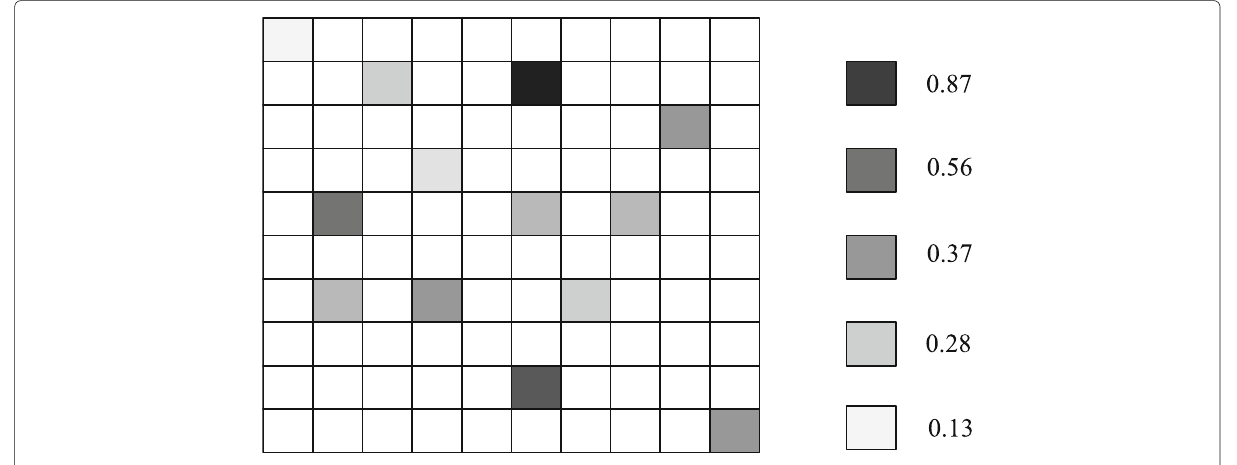
Fig. 3 The distribution of historical query